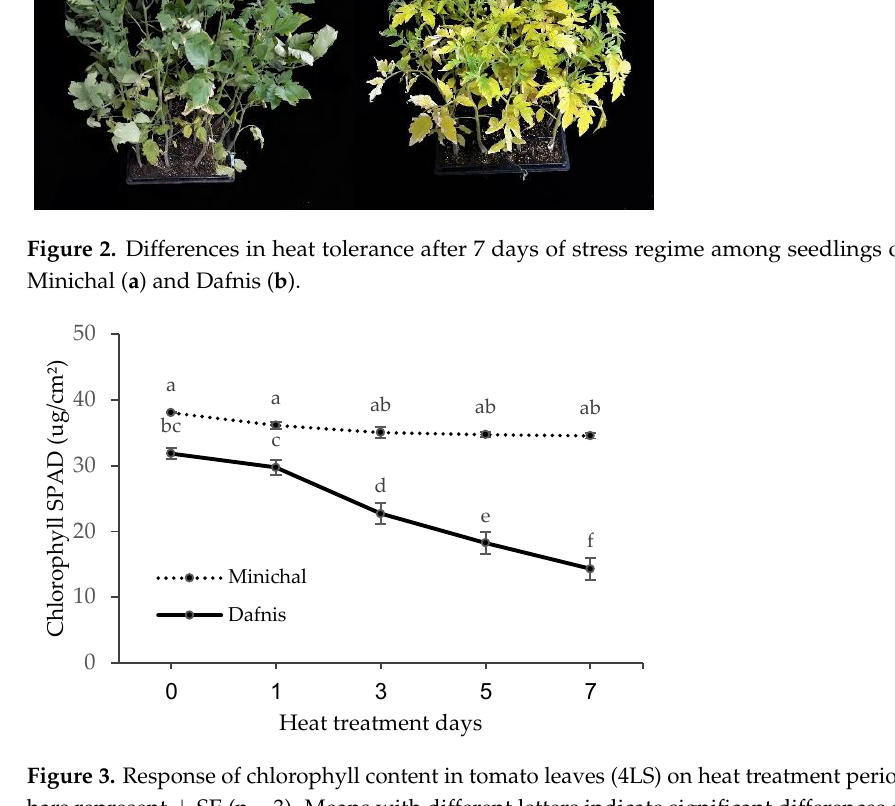
Figure 1. Changes in leaf heat damages among tomato cultivar seedlings Minichal and Dafnis. Vertical bars represent ± SD (n = 4). Means with different letters indicate significant differences at p ≤ 0.05.